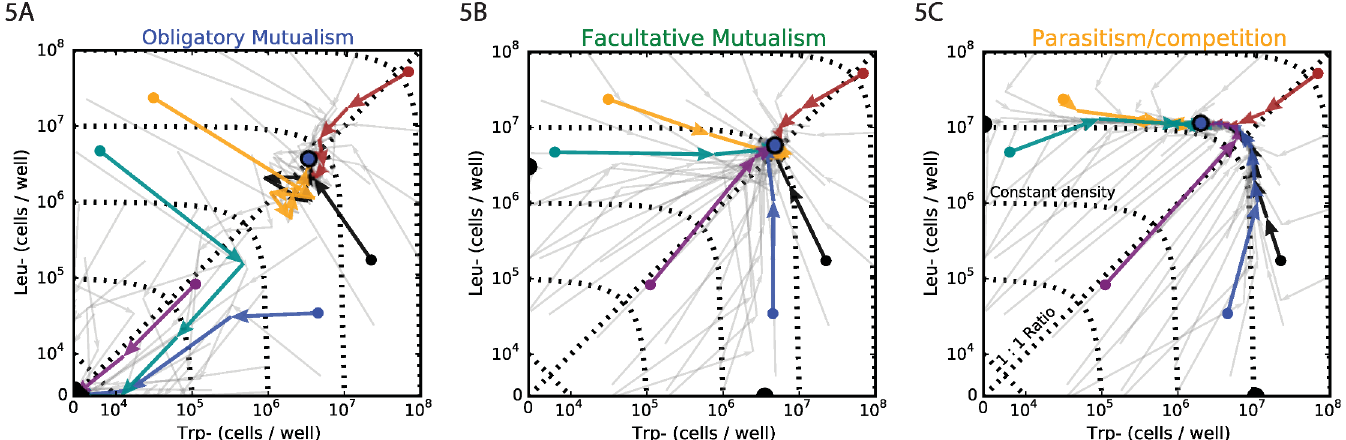
Fig 5. Relaxation dynamics is observed before population collapse. In each figure, we started co-cultures at 48 different population sizes ( n = X + Y ) and relative abundances ( f = X / Y ). Six co-cultures per figure are highlighted (colored arrows), with day 0 density represented by a colored dot and each arrow signifying the change over a single day. Black dots on the axes indicate monoculture equilibria, whereas the blue dot shows the co-culture equilibrium. (A) In obligatory mutualistic conditions, close to extinction, populations approach equilibrium from the direction corresponding to constant ratio, f . (B) In medium amino acid concentrations, there is no privileged direction for approaching equilibrium. (C) At high concentrations, when the two strains compete against each other, the population approaches equilibrium from the constant n manifold. Axes are linear at densities of 0 to 10 4 cells/well and logarithmic for higher densities.